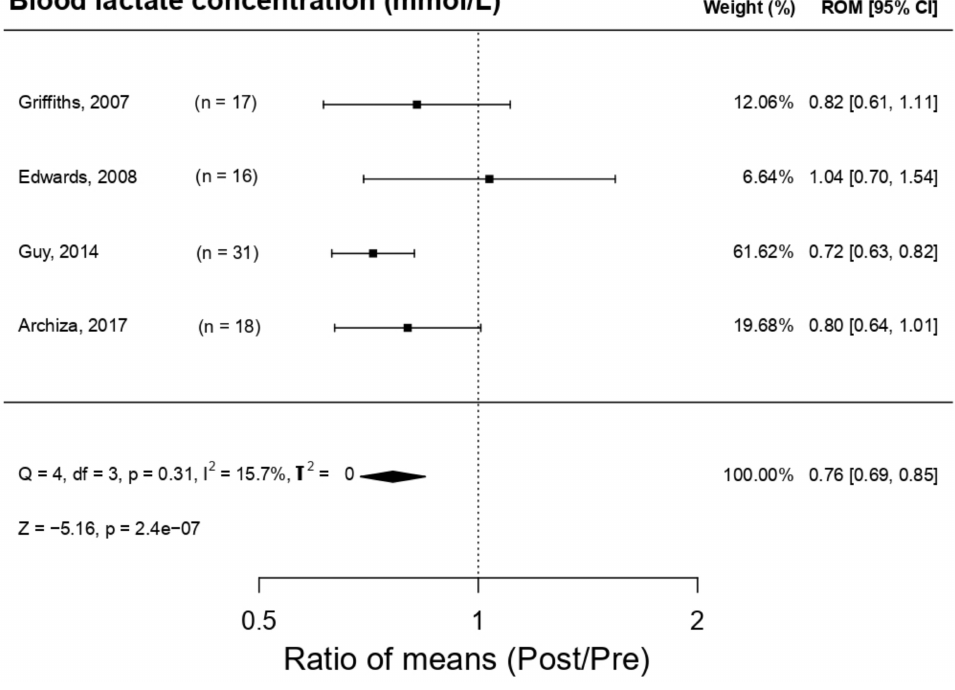
Figure 6. Forest plot of the meta-analysis of the effects of inspiratory muscle training with PowerBreath ® on blood lactate concentration. CI = Confidence Interval; ROM = Ratio of Means; Pre = Pre-inspiratory muscle training; Post = Post- inspiratory muscle training; Q = Cochran’s Q statistic; df: degrees of freedom; p = p -value (the first one refers to Cochran’s Q, the second one to Z); I 2 : I-square statistic; T 2 : Tau-squared; Z: Z-value.